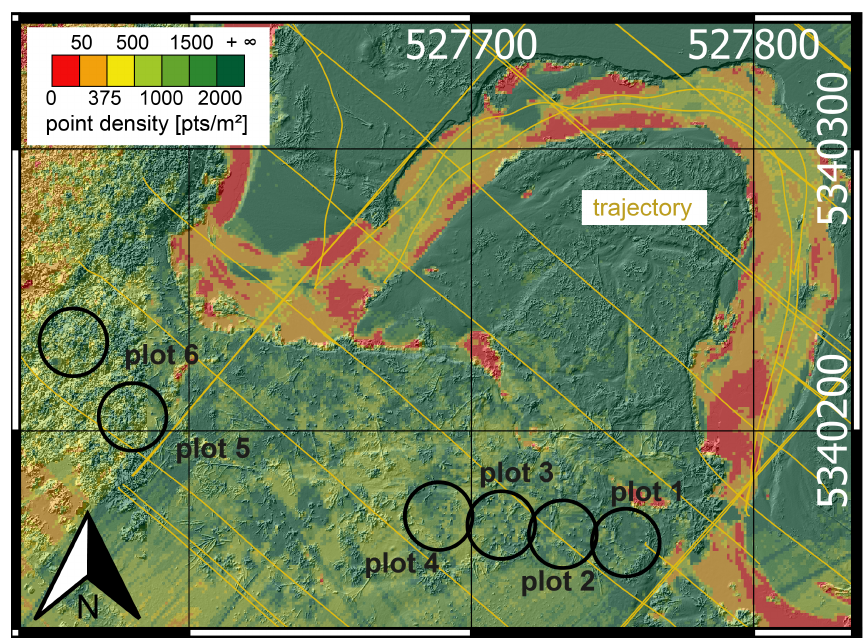
Figure 1. Neubacher Au, Pielach River, Lower Austria; Hill shading of near ground DEM superimposed with colored point density map including UAS flight paths (yellow) and positions of sample plot areas (black circles).